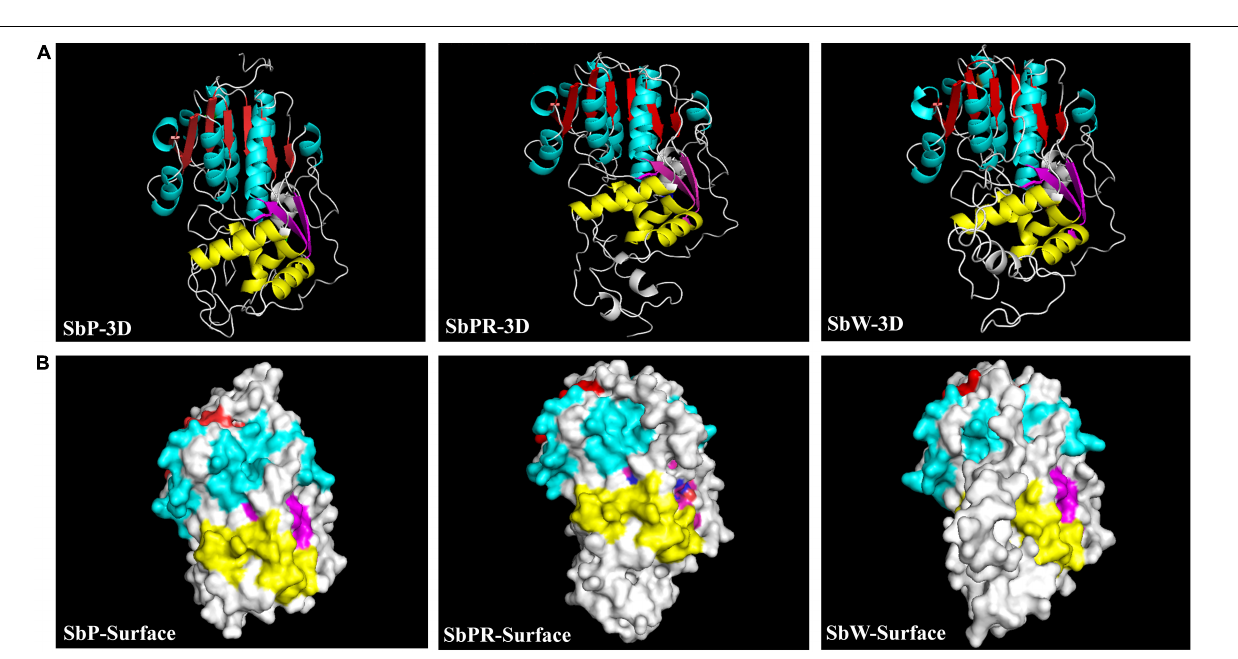
DFR were expressed to different degrees in three different flower colors of S . baicalensis . In SbPR vs. SbP, the structural